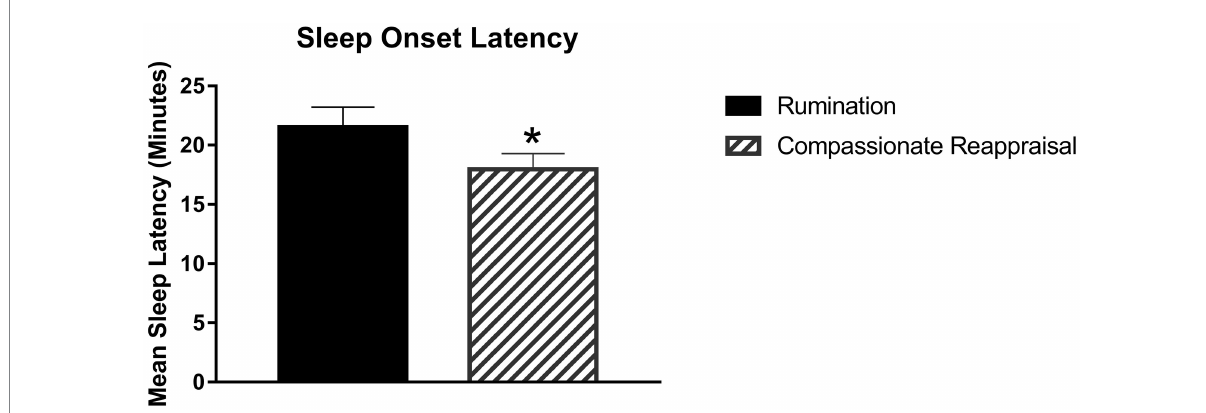
FIGURE 2 Sleep onset latency was significantly shorter indicating participants fell asleep faster following the compassionate reappraisal manipulation ( M = 17.96, SEM = 1.35) compared to after the rumination manipulation ( M = 21.51, SEM = 1.70), F (1, 169) = 4.15, p = 0.043. Error bars indicate Standard Error of the Mean (SEM). *Indicates p <